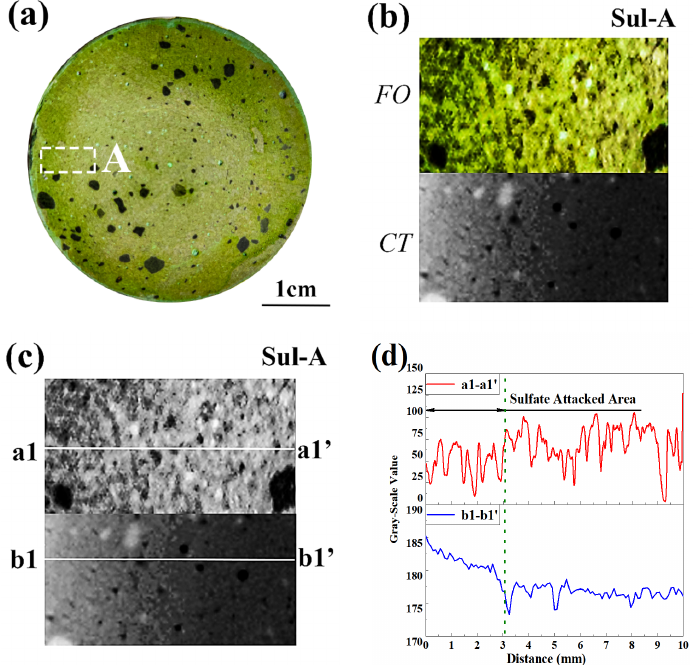
Figure 9. Partly leached specimen. ( a ) Cross-section sprayed with F. orchid indicator; ( b ) magnified local image of A and related CT image; ( c ) binarized image of ( b ); ( d ) 1D distribution of grayscale value along a1-a1 ′ and b1-b1 ′ in ( c ).